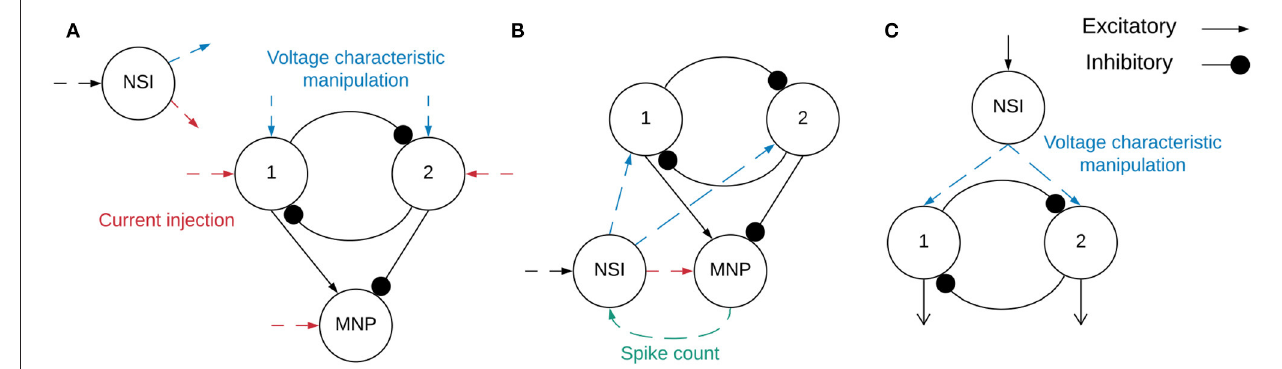
FIGURE 3 | (A) Block diagram outlining the network structure. Spiking neuron populations “1” (excitatory neuron population) and “2” (inhibitory neuron population) comprise the sCPG. The MNP is also spiking, it is regulated by an excitatory and inhibitory connection from the sCPG populations. The combination of the sCPG populations and the MNP create the complete sCPG network. The interneuron is non-spiking, communicating with the sCPG neuron populations through current injection and voltage characteristic manipulation. The MNP only receives current injections from the NSI. The neural network is altogether composed of 16 neurons, 5 neurons per population plus a single NSI. Red dashed lines indicate input and output of current between different neurons while blue dashed lines mark voltage characteristic manipulations. The dashed lines do not show direct connections because testing combined different configurations of current injection and voltage characteristic manipulation. (B) Network for regulating output signal amplitude using the MNP spike count. The total number of spikes output by the motor neurons during the latest time step is sent to the NSI to determine the size of the current injection to the MNP. (C) The event-based network consisting of an sCPG of two single AdEx neurons. The Vth of each AdEx neuron is manipulated by an NSI based on spiking